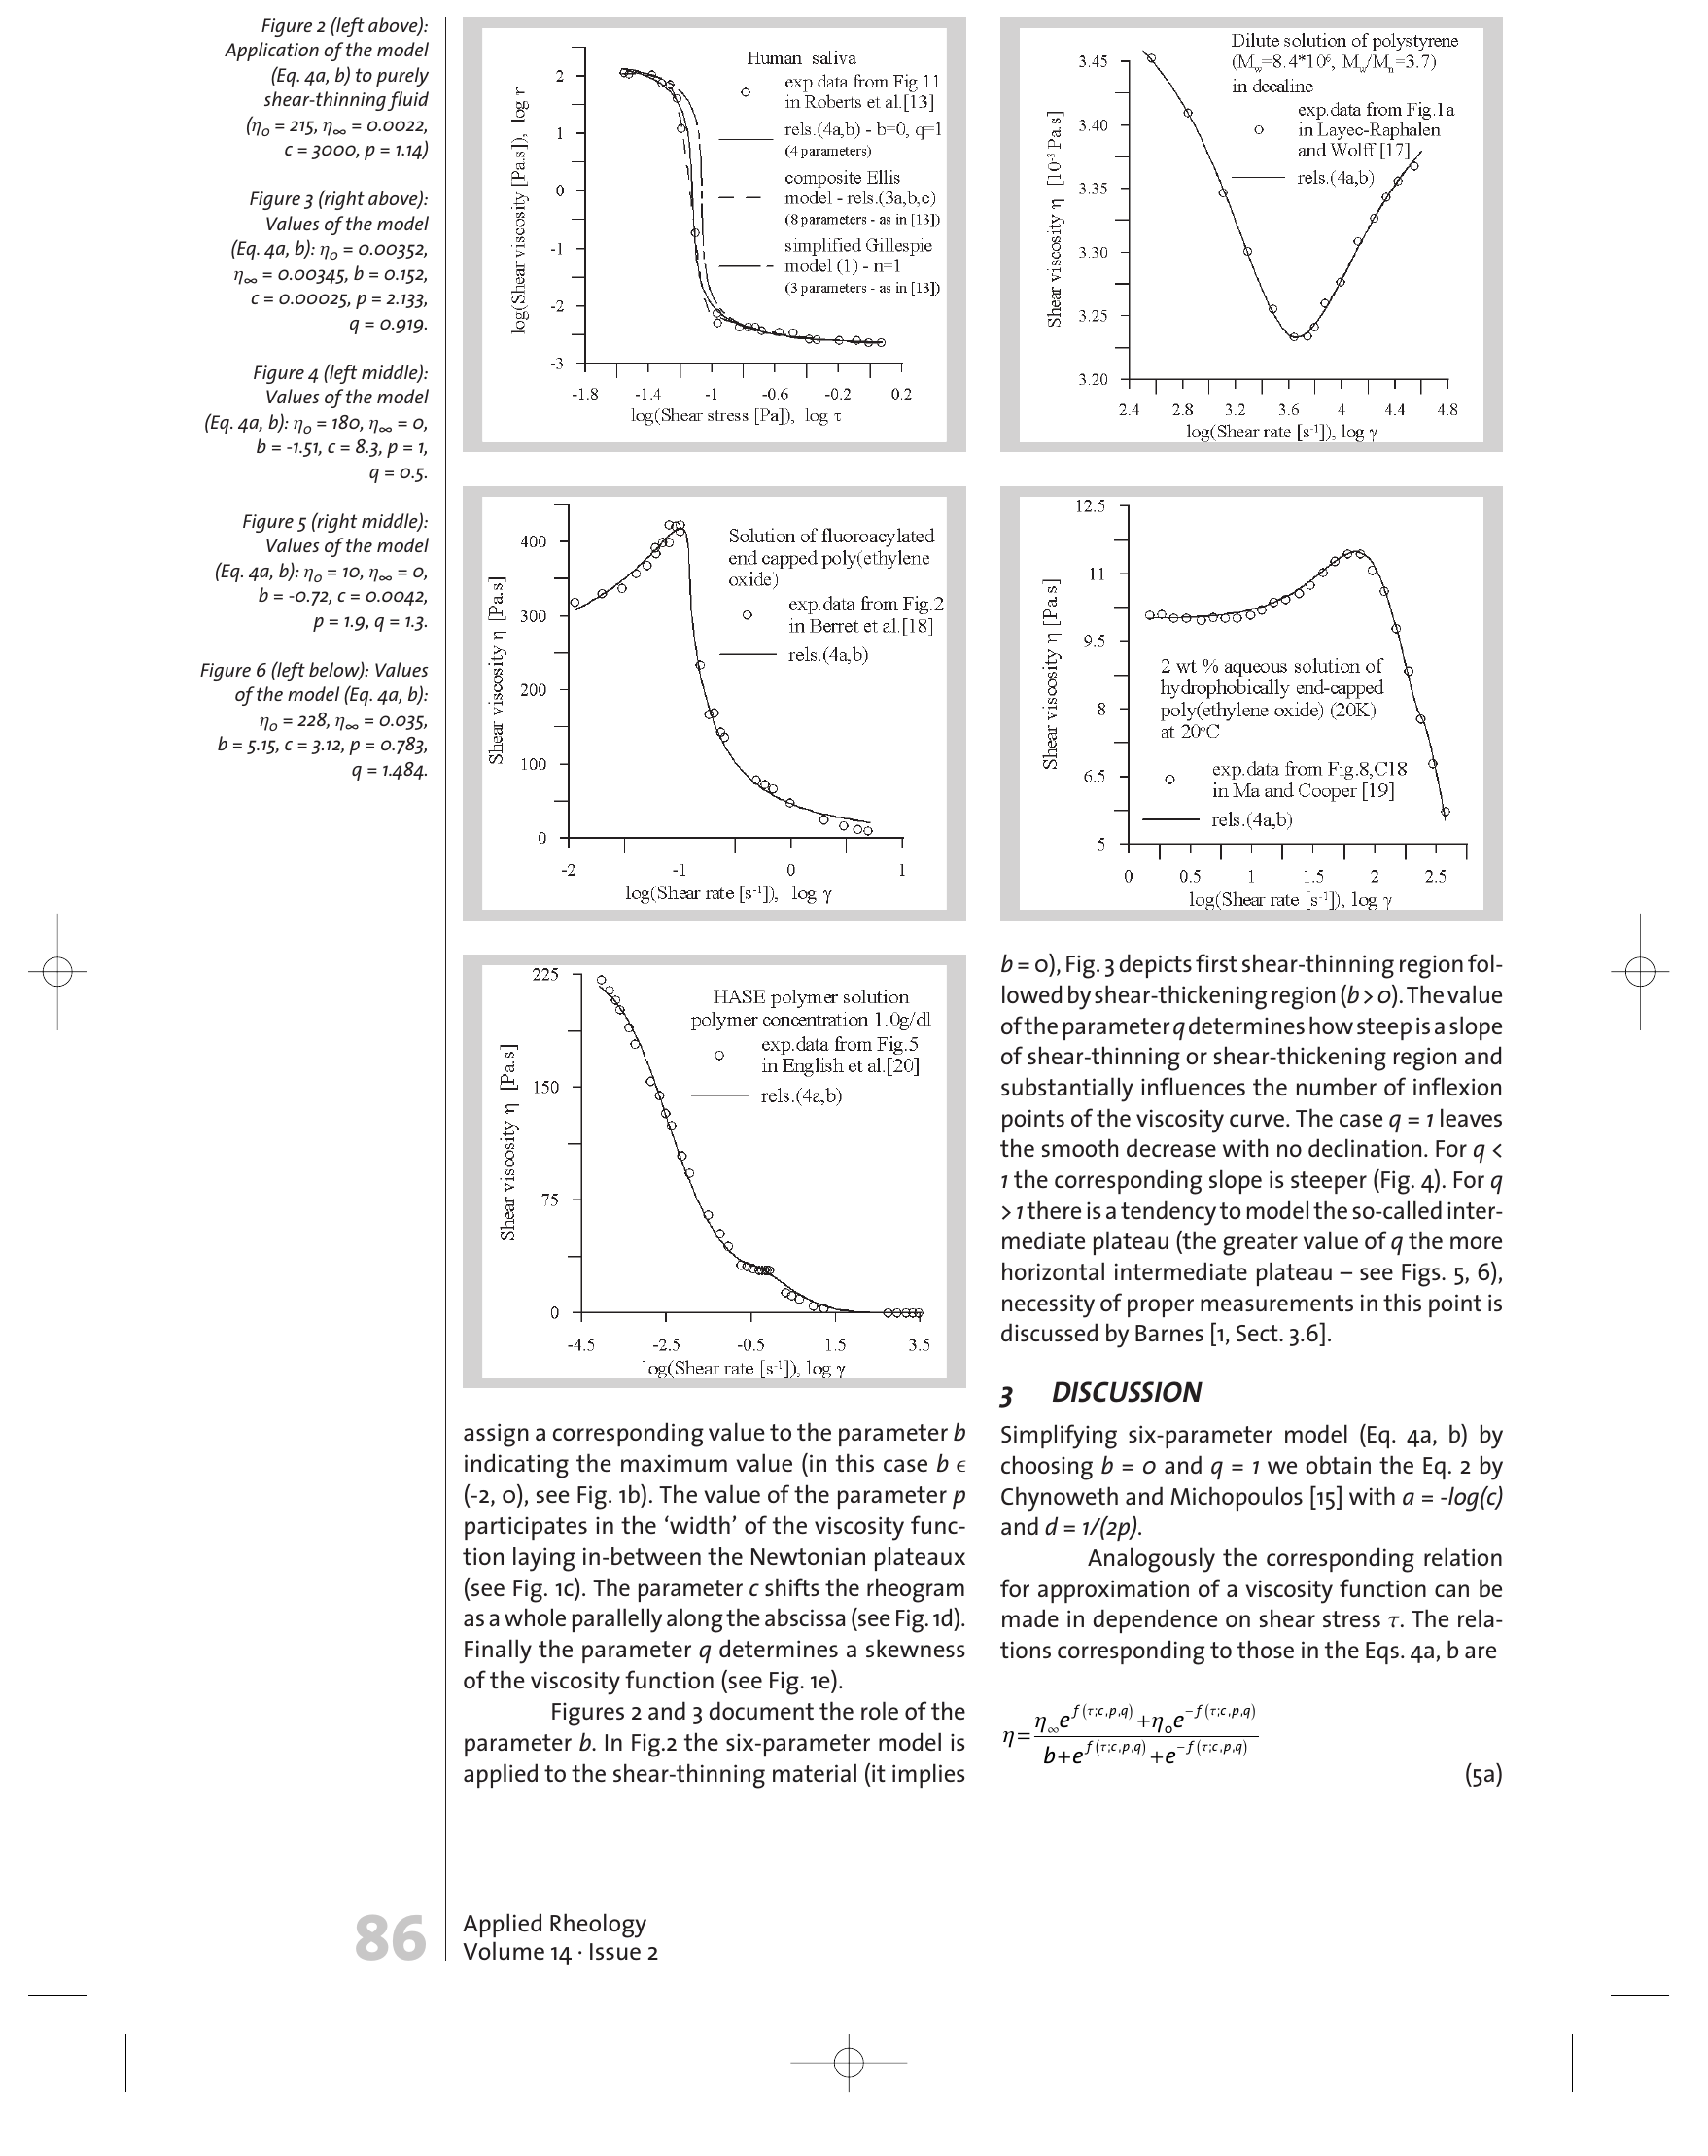
Figure 4 (left middle): Values of the model (Eq. 4a, b): h 0 = 180, h ∞ = 0, b = -1.51, c = 8.3, p = 1, q = 0.5. Figure 5 (right middle): Values of the model (Eq. 4a, b): h 0 = 10, h ∞ = 0, b = -0.72, c = 0.0042, p = 1.9, q = 1.3. Figure 6 (left below): Values of the model (Eq. 4a, b): h 0 = 228, h ∞ = 0.035, b = 5.15, c = 3.12, p = 0.783, q =